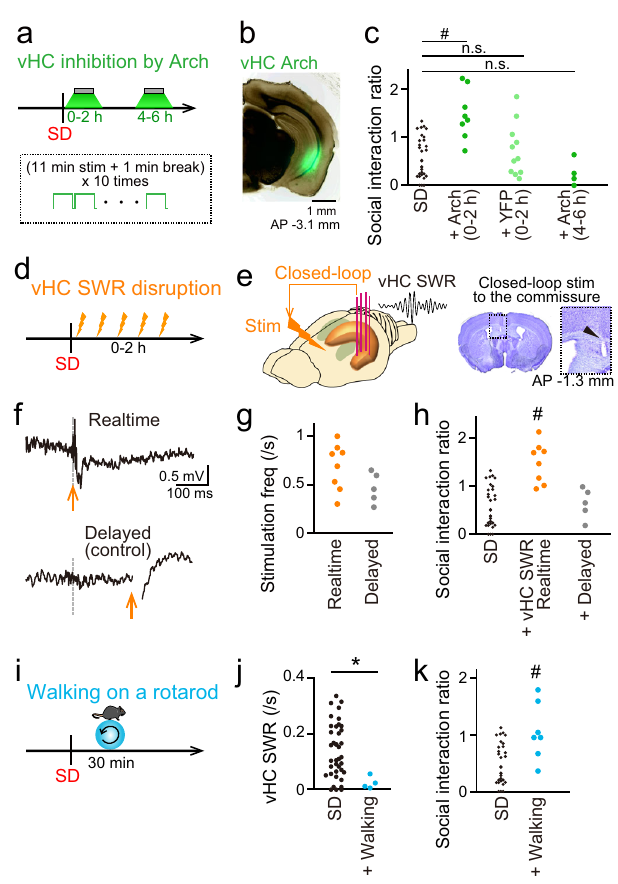
Fig.5|SuppressionofpoststressventralhippocampalSWRsrescuesSIde fi cits. a Experimental timeline of optogenetic inhibition (11-min green light laser pulses ( λ = 532nm; 1 – 2mW) with intervals of 1min) of the ventral hippocampus by Arch 0 – 2h (Arch (0 – 2h)) and 4 – 6h (Arch (4 – 6h)) after SD. b Arch-EYFP expression in the vHC. c SIratios of SDmiceafter vHCArch photostimulation ( n =31, 8, 11, and 4 mice). SD versus Arch(0 – 2h), Z =3.60, # P =6.3×10 − 4 ; SD versus YFP(0 – 2h), Z =0.66, P >0.99; SD versus Arch(4 – 6h), Z =1.61, P =0.22, two-sided